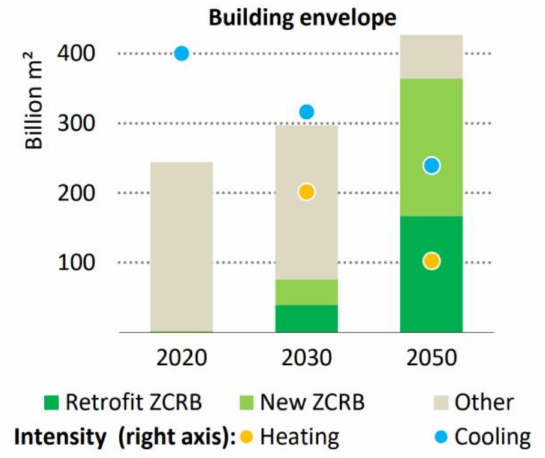
Figure 11. Targeted retrofitting of existing building to achieve zero carbon ready building and upcom-